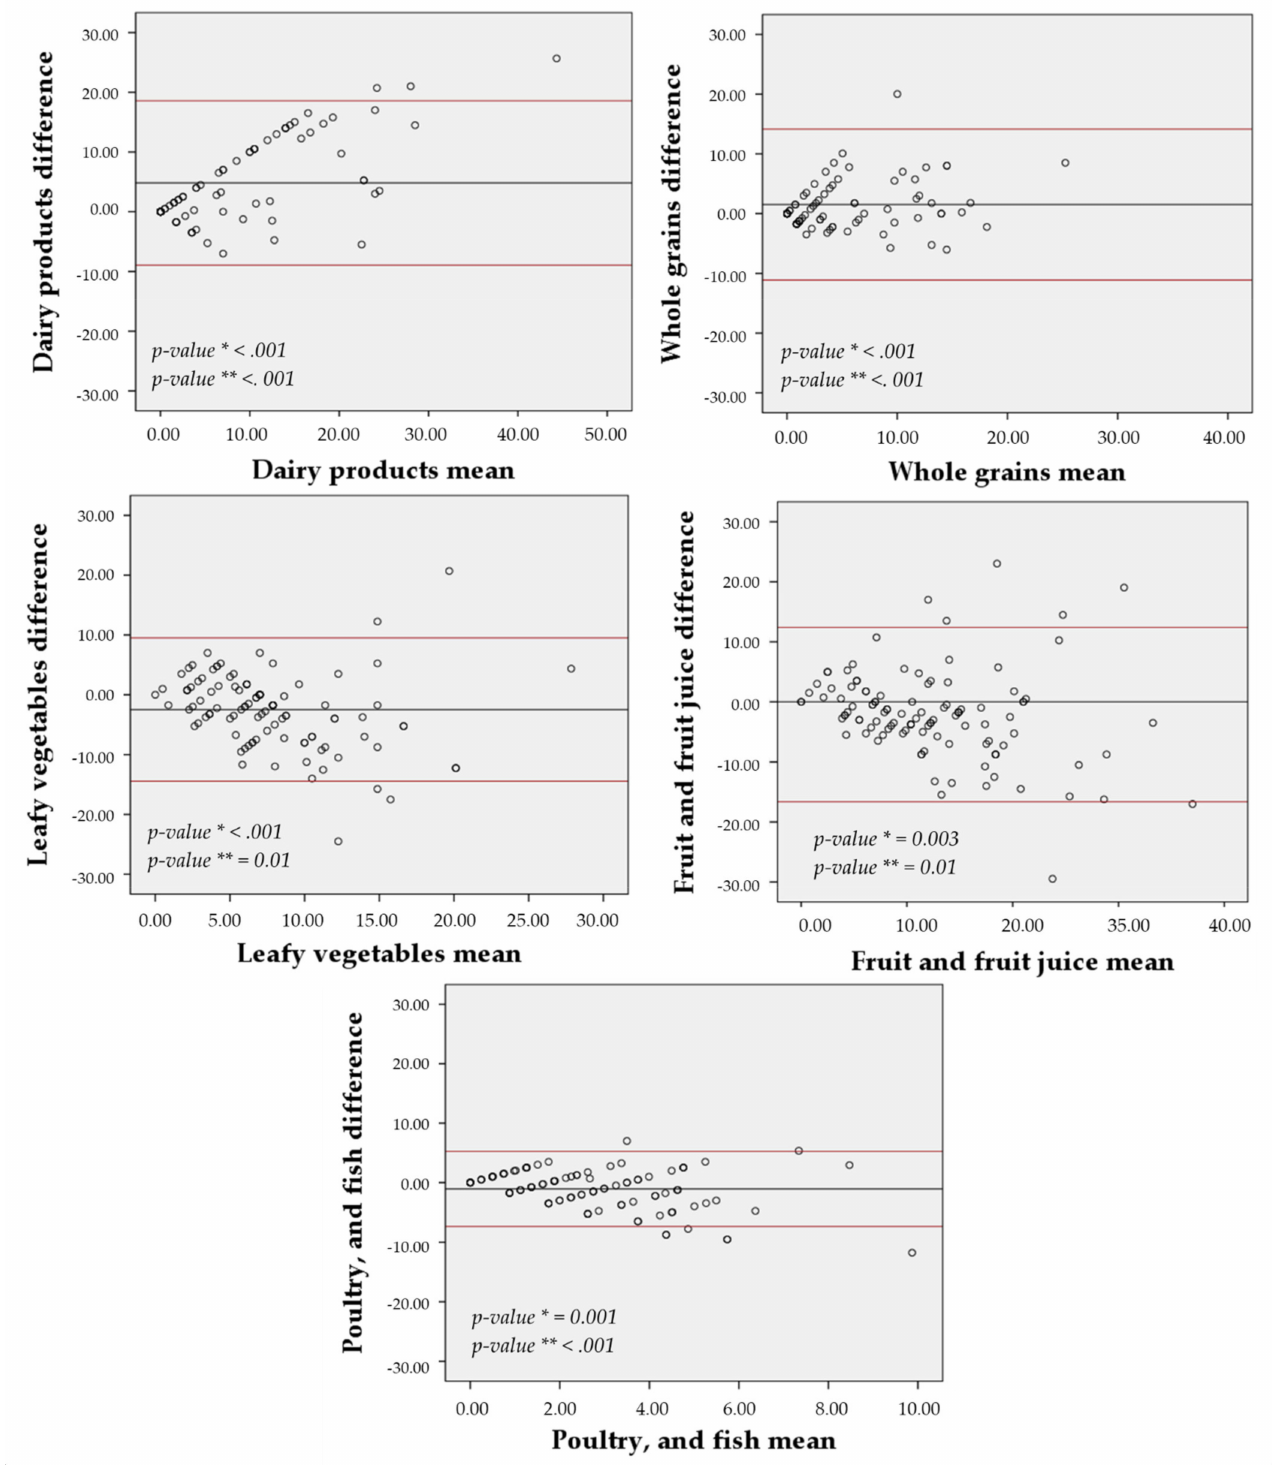
Figure 4. Bland-Altman agreement between the 30-day FG-QFFQ with the 24-h dietary recalls. * p -value for non-zero difference between methods ( t -student test) and ** p -value for propensity bias (regression